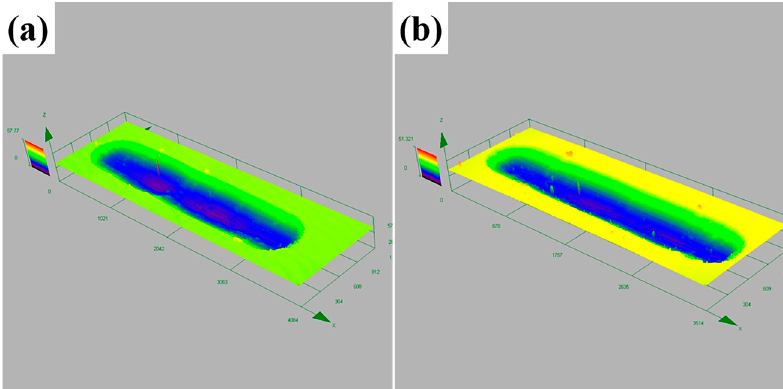
Figure 11. 3D-profile of the wear tracks for ( a ) polished and ( b ) USRP treated titanium after 6 min sliding time.